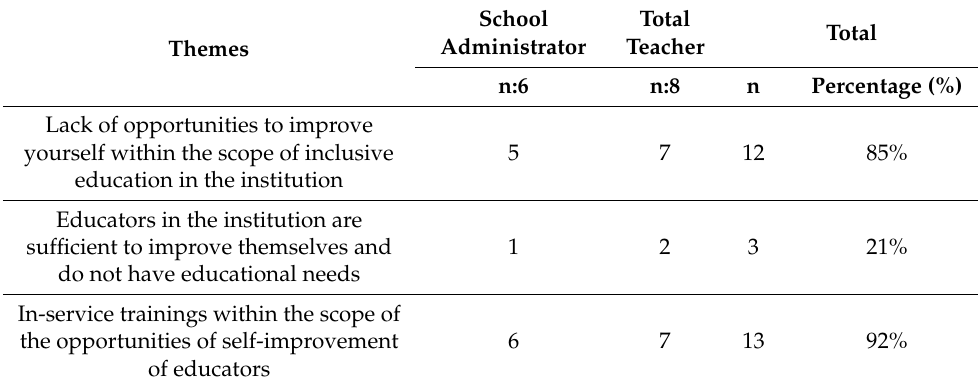
Table 4. The situation and solution of the institution’s research and development opportunities for school administrators and teachers in the issue of inclusive